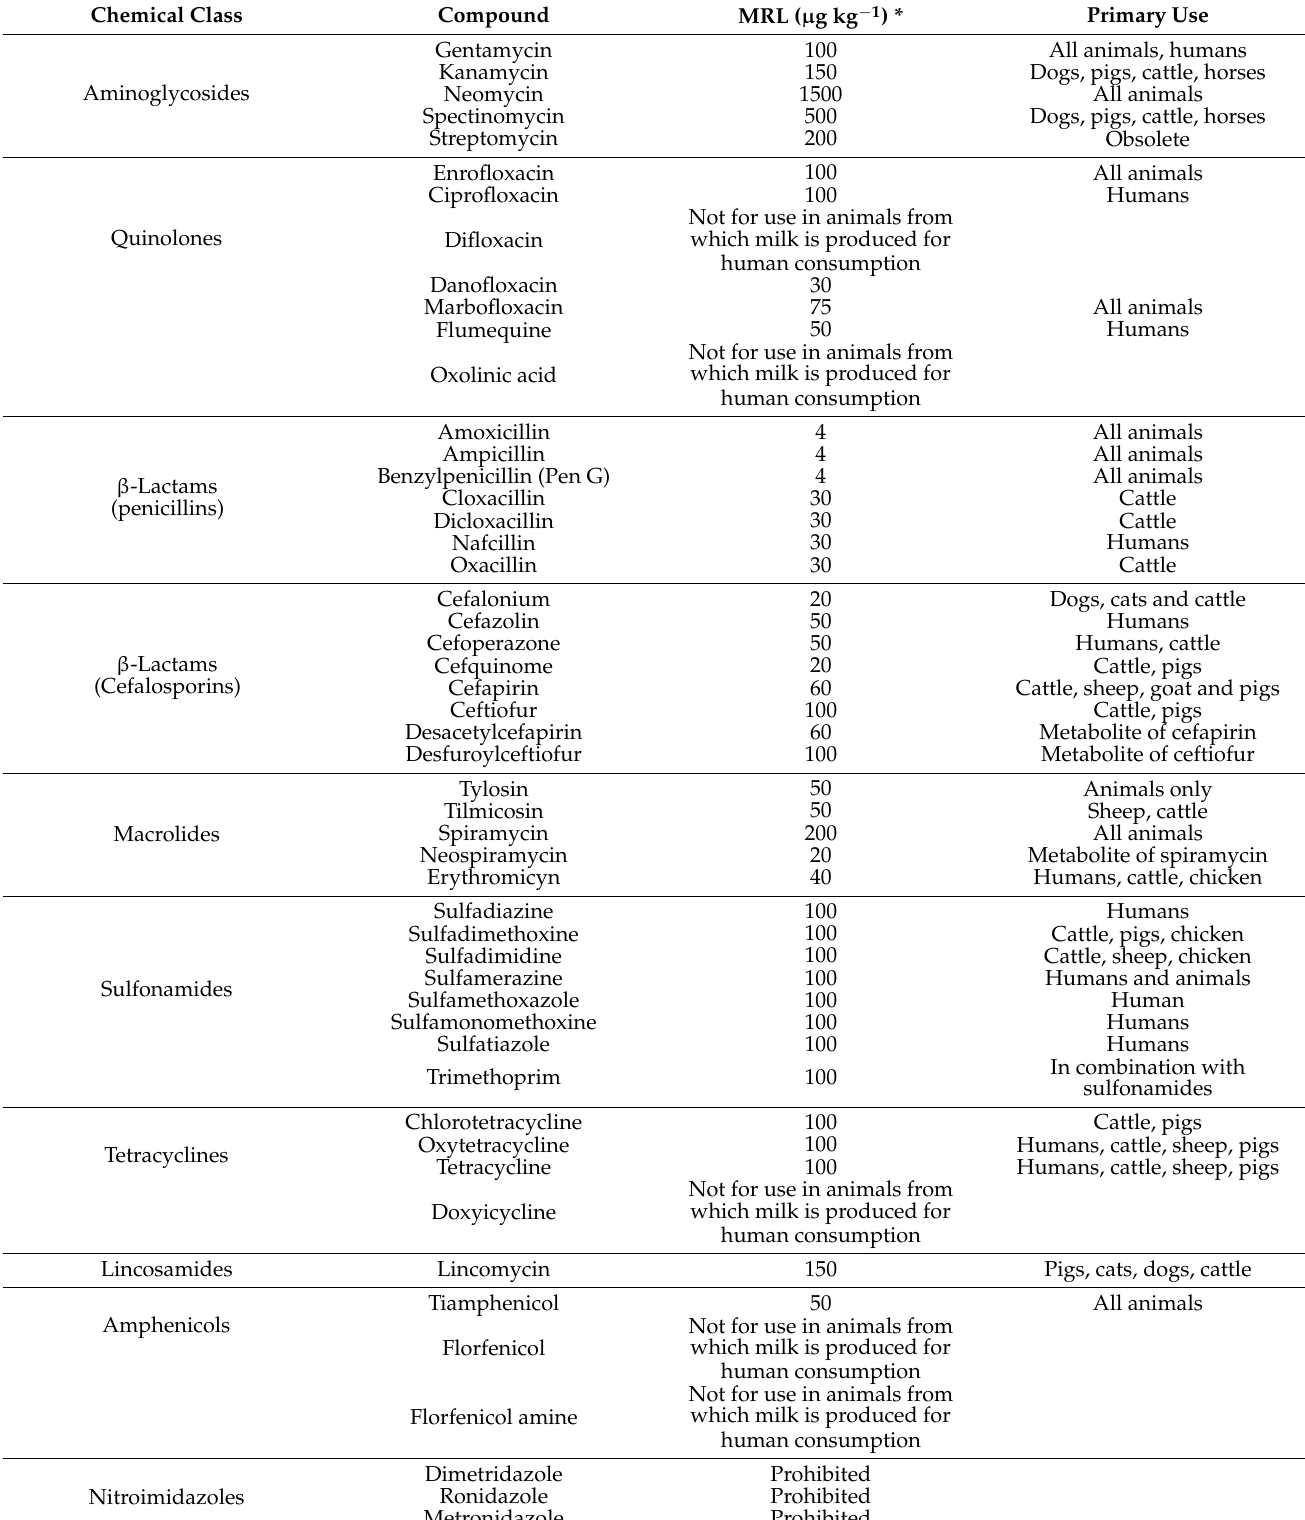
Table 1. Antibiotics used in human medicine and/or dairy animals (adapted from